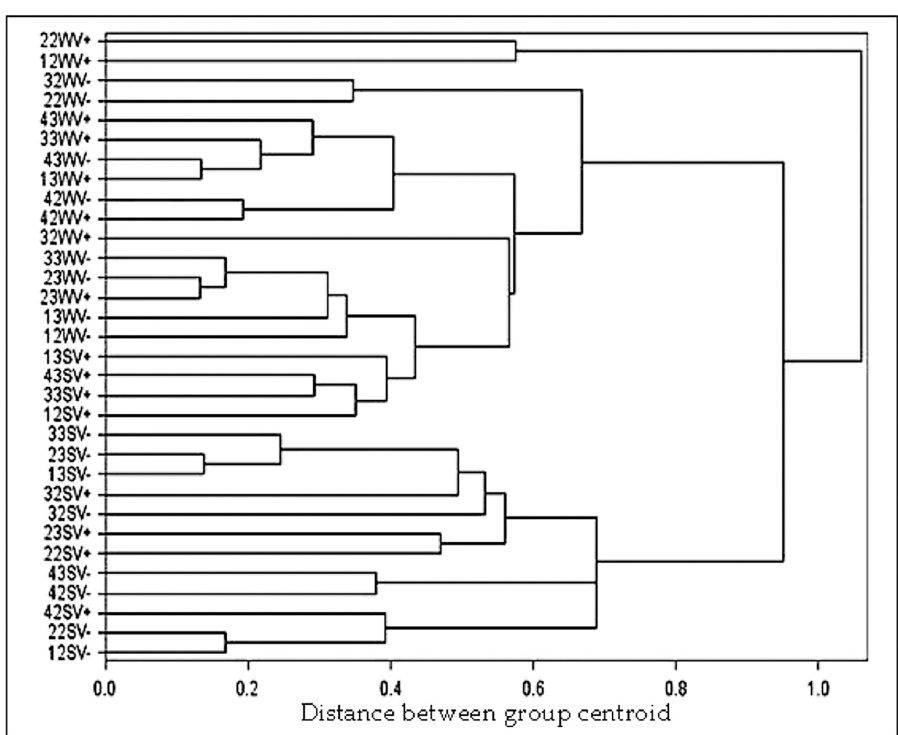
Figure 1. Dendrogram of hierarchical clustering analysis of the four microenvironment (SV − , SV + , WV − , and WV+) obtained by analyzing the meteo-climatic indices reported in Table 2. (1, 2, 3, and 4, as the first digit in the treatment acronym, correspond to the phenological period; 2, 3, as the second digit, correspond to the season 2012 and 2013, respectively; W and S represent the West and South vineyard aspect, respectively; V+ and V − indicate a higher or lower plot vigor, respectively).